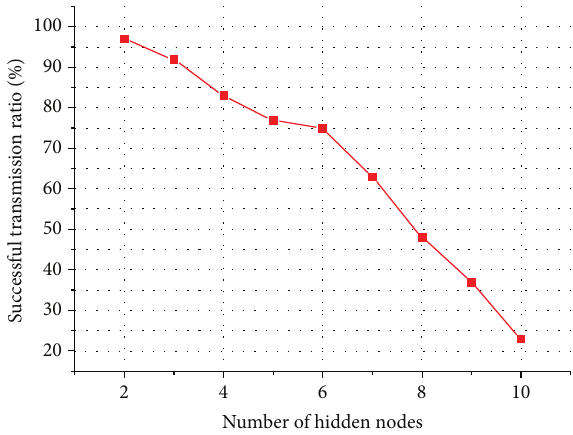
Figure 6: Number of hidden nodes versus packet success